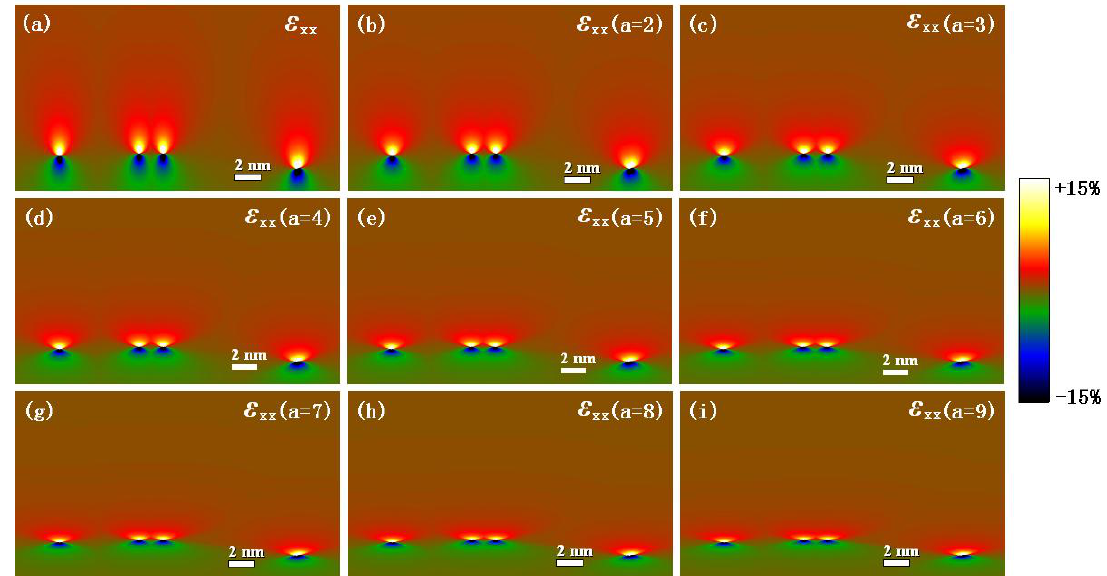
Figure 6. Theoretical strain fields at the Ge/Si heterostructure interface given by the Peierls-Nabarro and Foreman dislocation models: ( a ) Strain component ε Peierls-Nabarro model; ( b – i ) Strain components ε factor a given by Foreman